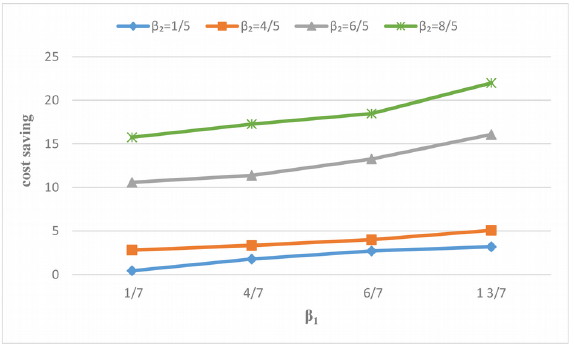
Figure 6. The cost saving with various β